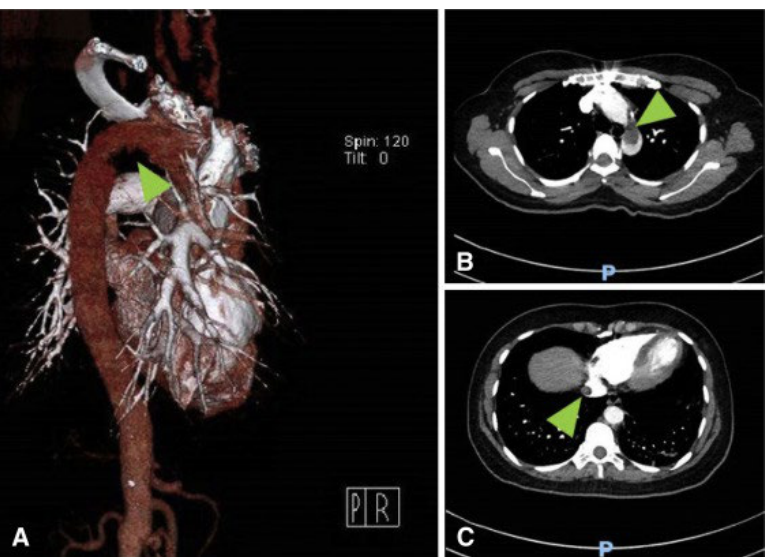
Figure 8. (A) CT with three dimensional reconstruction of the aortic arch with a filling defect (arrow); (B) coronal view of the chest,